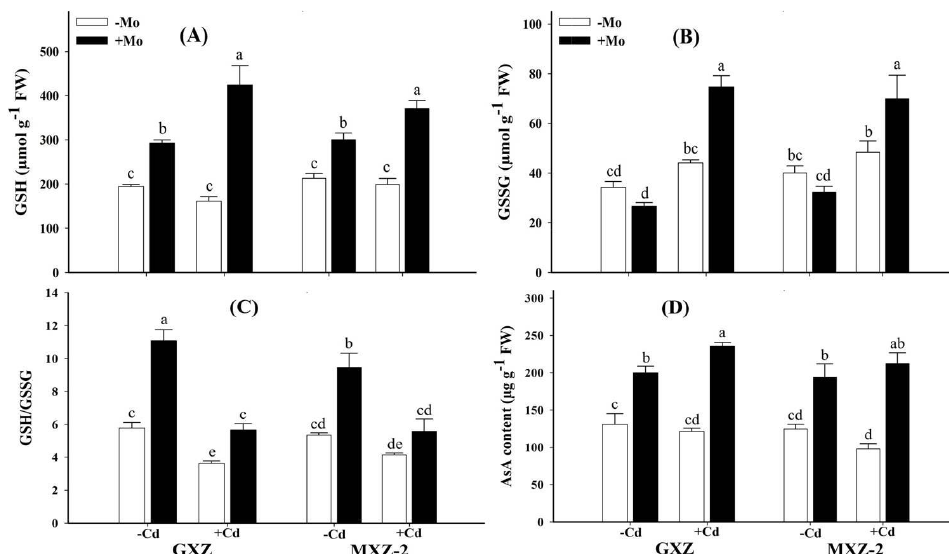
Figure 5. Influence of molybdenum (Mo) and cadmium (Cd) on; ( A ) reduced glutathione (GSH), ( B ) oxidized glutathione (GSSG), ( C ) ratio of GSH/GSSG and ( D ) ascorbic acid (AsA) contents in leaves of two fragrant rice Guixiangzhan (GXZ) and Meixiangzhan-2 (MXZ-2) cultivars. Both fragrant rice cultivars were treated with two molybdenum levels: 0 µM (–Mo) and 1 µM (+Mo), against two cadmium levels: 0 µM (-Cd) and 100 µM (+Cd) in modified Hoagland solution. Vertical bar above indicates standard error of four replicates. Different lowercase letters (a, b, c, etc.) represent significant differences according to the LSD-test ( p < 0.05, n = 4).